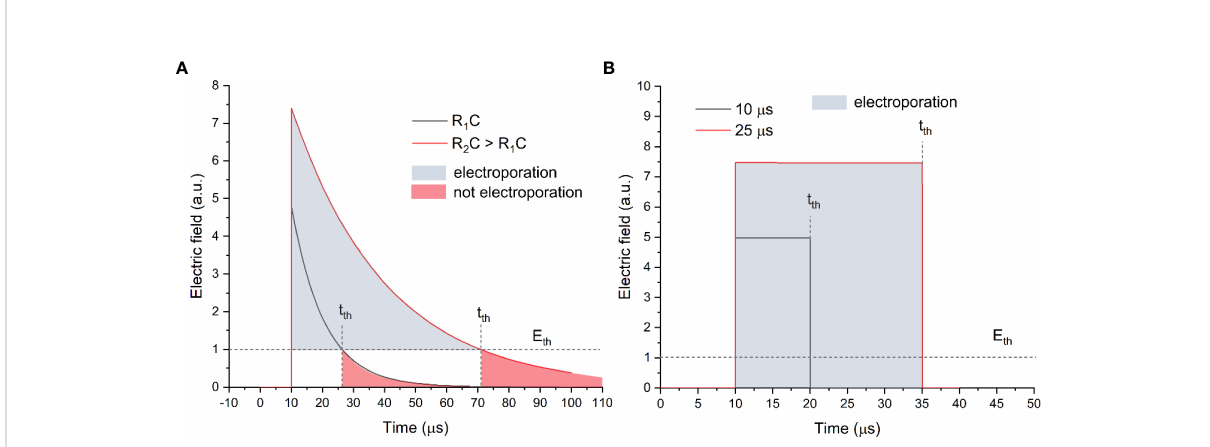
FIGURE 1 The exponential decay (A) and square wave (B) pulse waveforms, where t th is the time when the amplitude drop below the electric fi eld value required for electroporation (E th